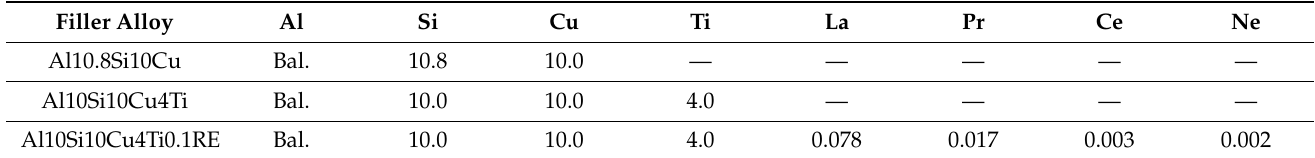
Table 1. The chemical composition of the filler alloys used in the study (wt.%).